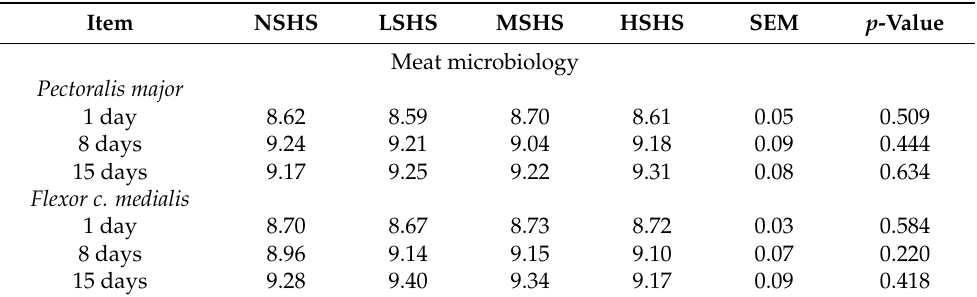
Table 5. Effects of the level of electrical stunning, halal neck cutting, and subsequent bleeding on the Pectoralis major and Flexor cruris medialis microbial loads (Log 10 cfu/g) in broiler